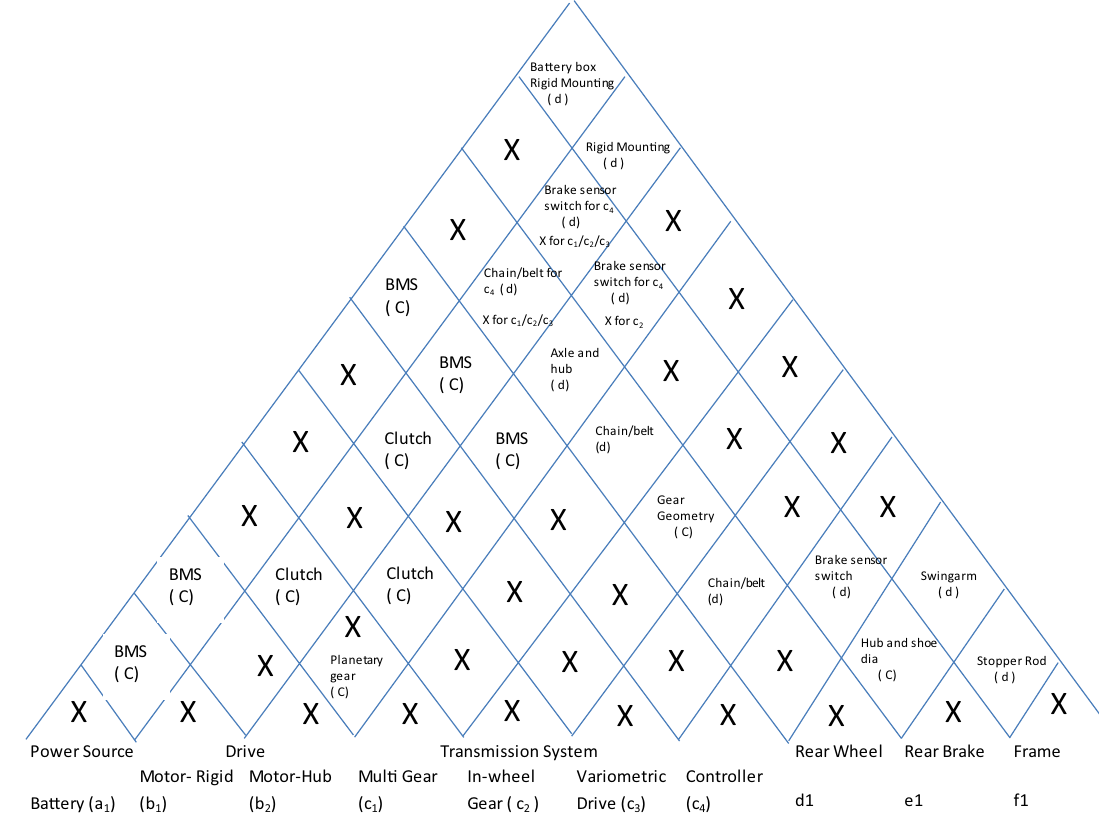
Table 18. Mapping the interfaces for the new product.